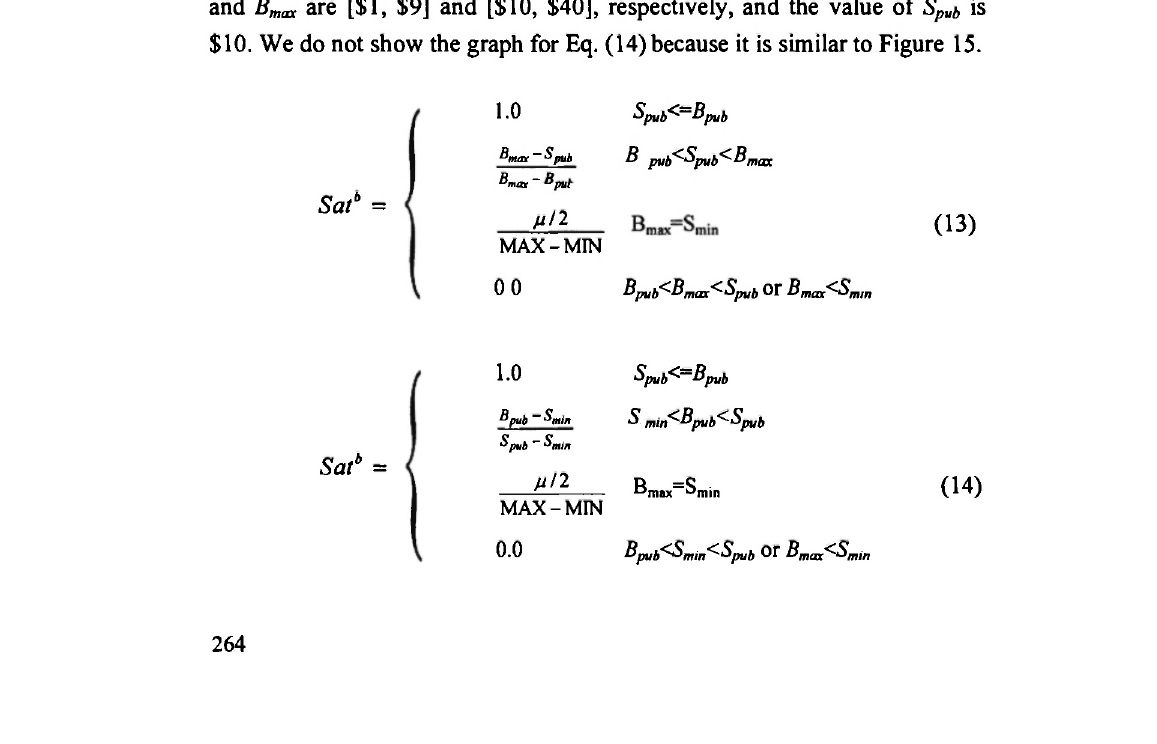
Fig. 15: Buyers' satisfaction degree when sellers' private prices are unknown and published prices are within [B /mh , B max